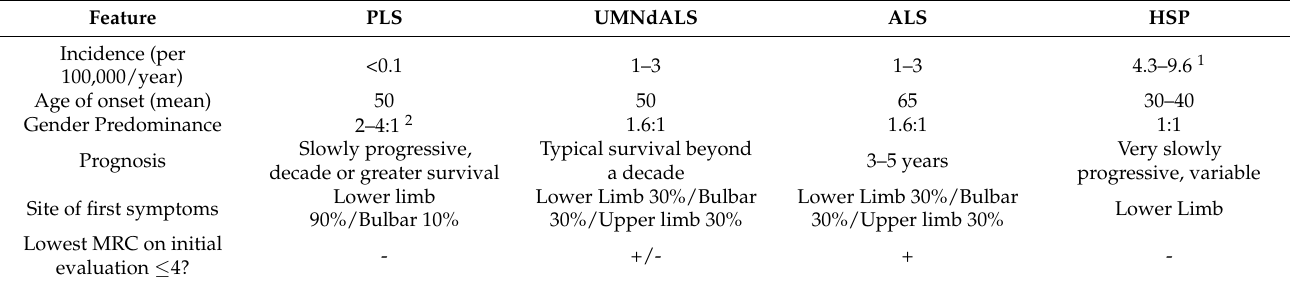
Table 1. Key clinical differences between PLS, UMNdALS, ALS, and